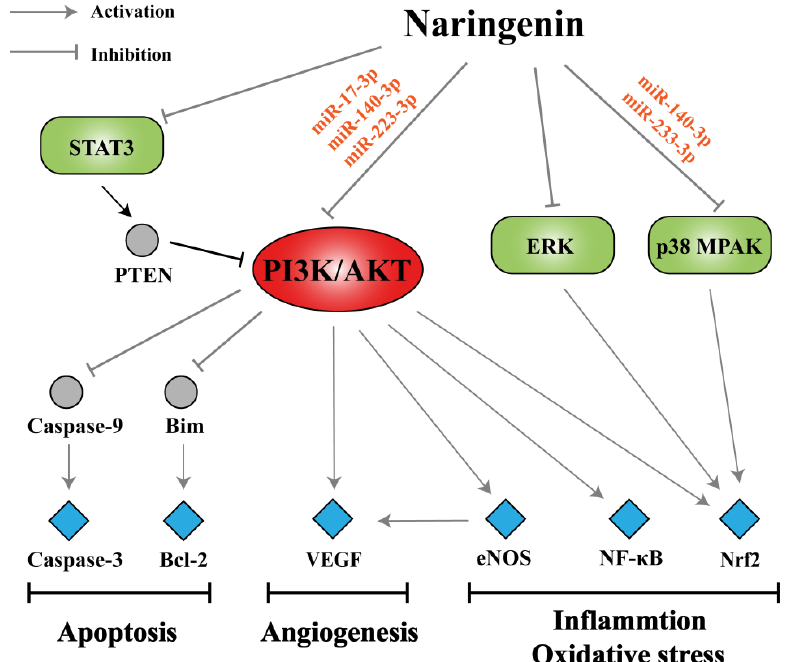
Figure 7. Summary of potential mechanisms of naringenin in the treatment of COPD. Naringenin has been shown to act on various signaling pathways such as phosphatidylinositol 3-kinase (PI3K)/protein kinase B (AKT), STAT3, p38 mitogen-activated protein kinase (MAPK), and extracellular signal-regulated kinase (ERK) pathways probably through specific miRNAs. The PI3K/AKT pathway, a bridge in the regulatory network, can activate downstream effectors including caspase-3, Bcl-2, VEGF, eNOS, NF-κB, and Nrf2 thereby participating in the processes of apoptosis, angiogenesis, inflammation, and oxidative stress in COPD